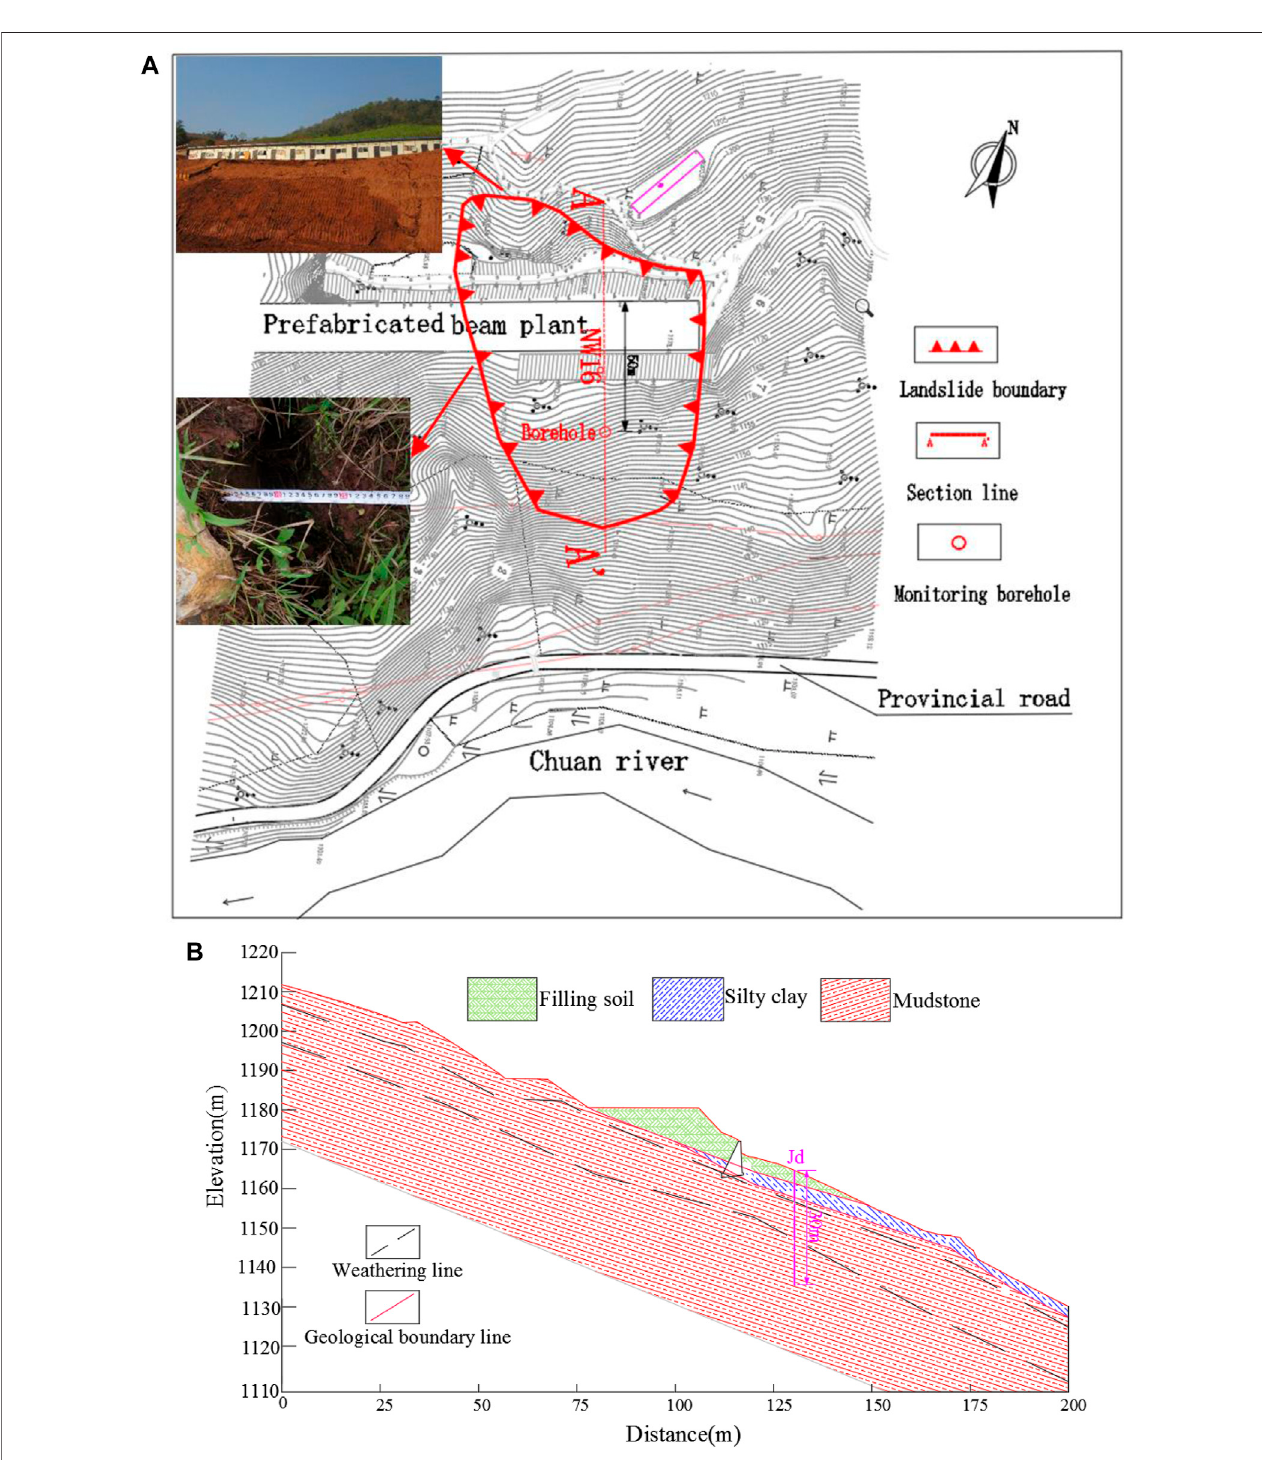
FIGURE12| TheWendongTownLandslide: (A) topographicmapshowinglandslideboundary,cracks,monitoringborehole,sectionline,andelementsatrisk; (B) cross-section along A-A ′ showing the silty clay, fi lling soil, mudstone, and monitoring borehole.